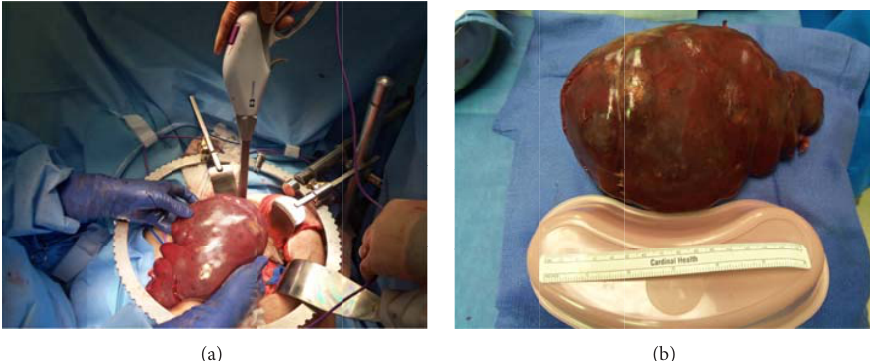
Figure 3: (a) Splenectomy with distal pancreatectomy and (b) enlarged dark brown, soft, and rubbery spleen measuring 19.0 × 13.0 × 10.5 cm.